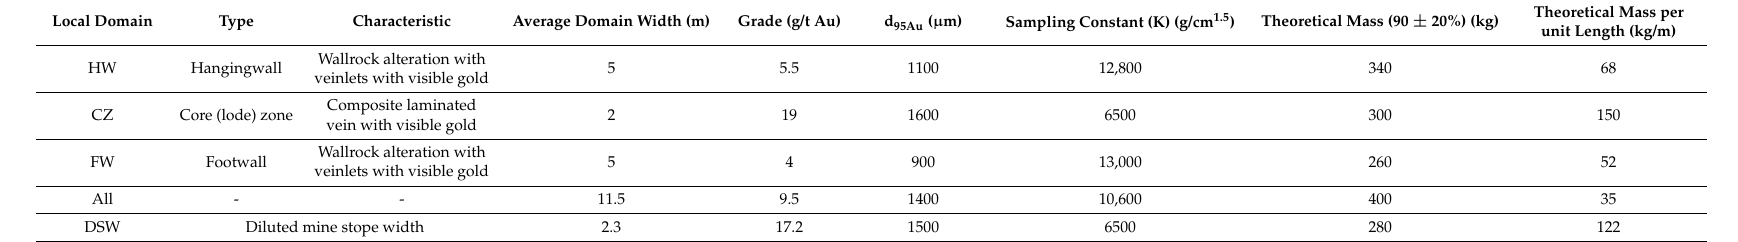
Table 8. Example of sampling characteristics for mesothermal lode/sheeted vein mineralisation across local domains (after [54]).